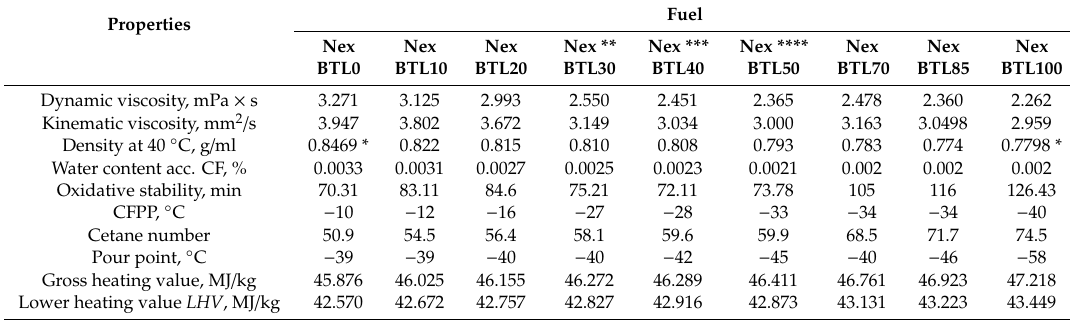
Table A1. Main parameters of tested